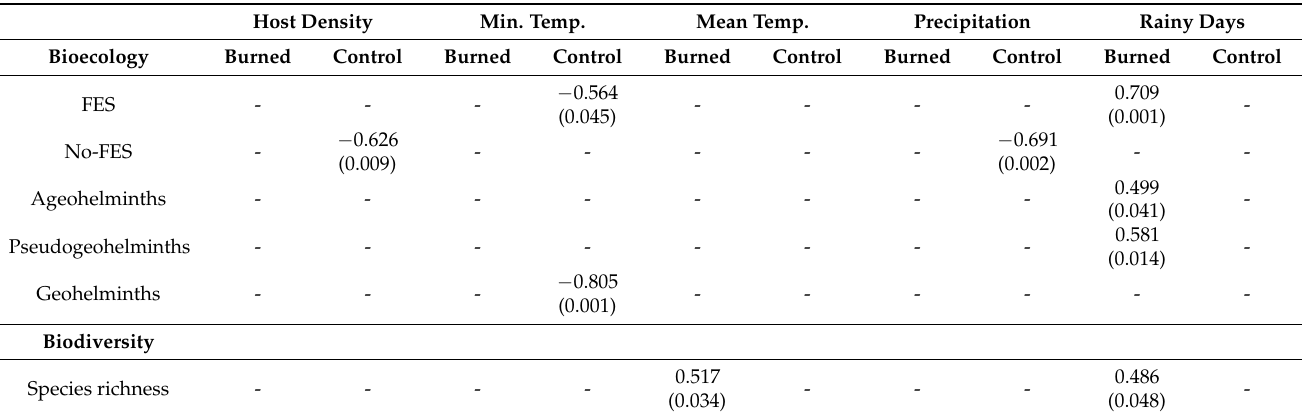
Table 9. Values of correlations between the prevalence of the different kinds of life cycles and values of species richness and the Brillouin index with climate data and host population density (values of the year prior to capture) by means of the Spearman correlation coefficient (Rho) and the associated P values in parentheses. Host Density Min. Temp. Mean Temp.